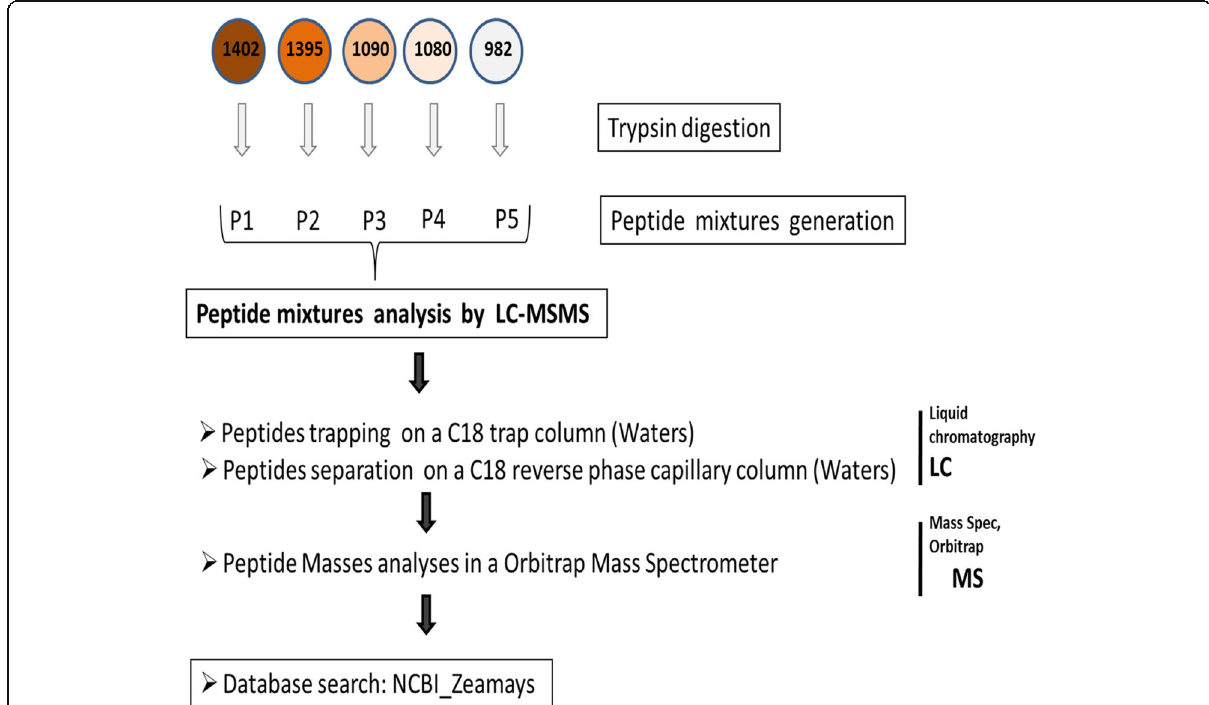
Fig. 6 Protein identification by LC-MSMS procedure for the five picked off spots